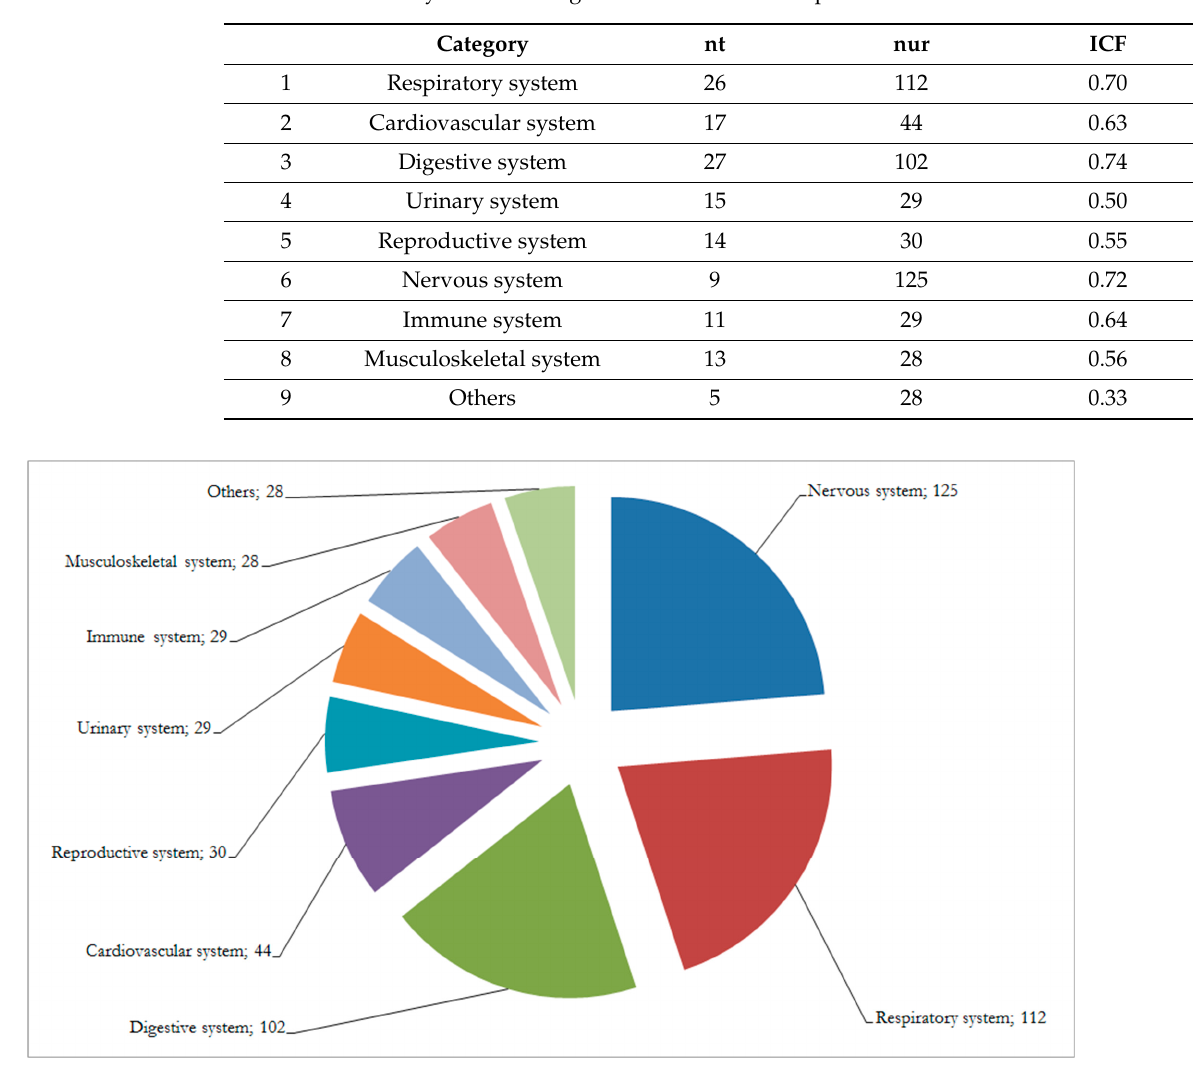
Figure 2. Factor diagram of disease categories in the Central Rhodopes, according to the number of mentions Σ U .